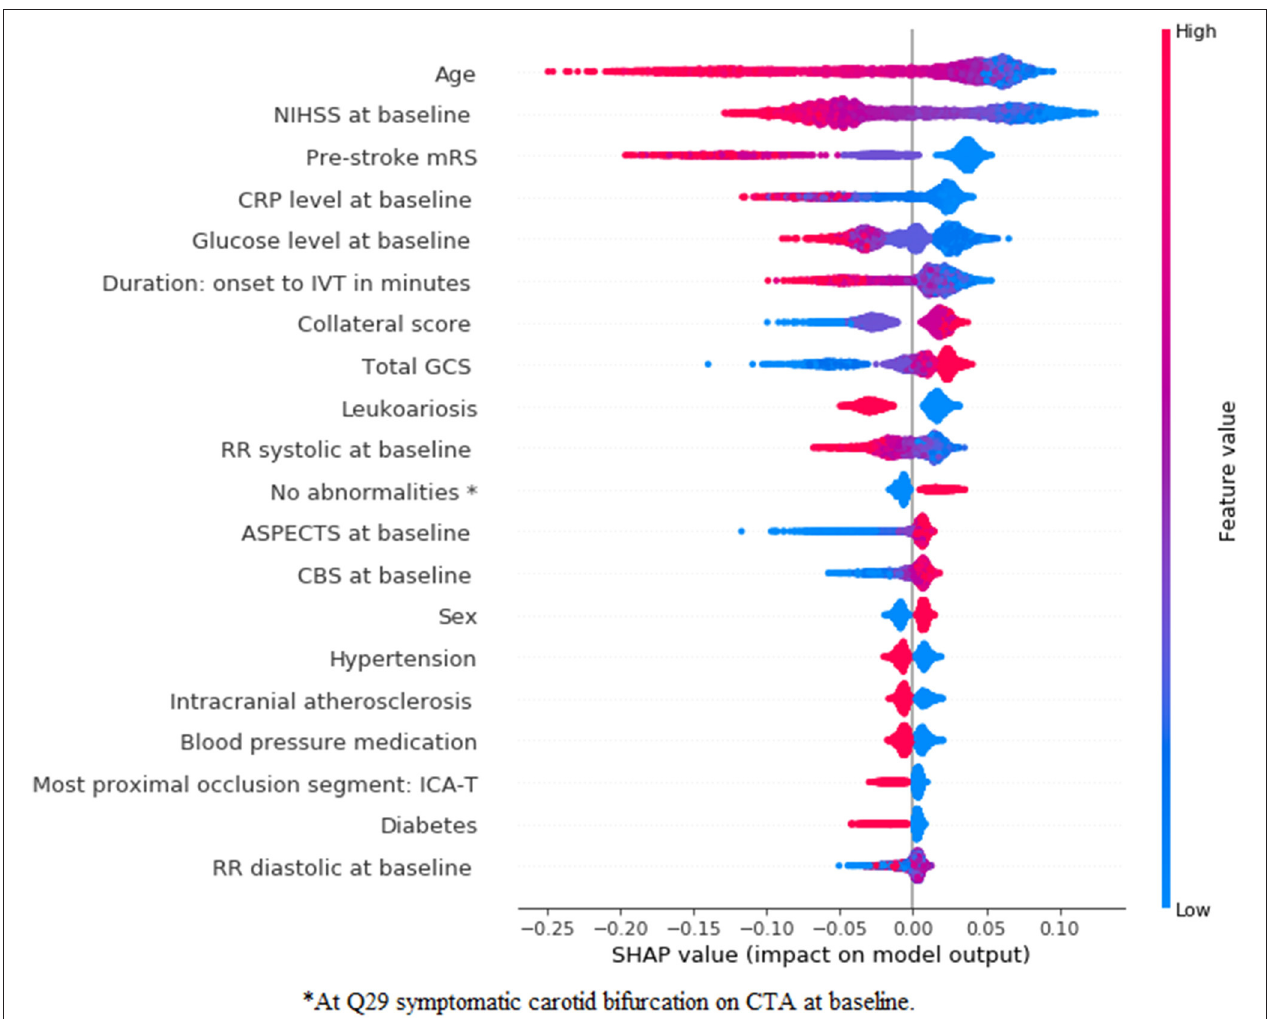
FIGURE 5 | SHapley Additive exPlanations (SHAP) feature importance for the clinical experiment for mRS prediction using the random forest classifier (RFC) model. For visualization purposes, we included only the top 20 features. Features are shown in order of importance, from most important (top) to less important (bottom). The color legend on the right shows how the feature values influence outcome: high values are depicted in red, while low values are presented in blue. Positive SHAP values (above zero in the x -axis) mean that the feature values are associated to the positive outcome (in this case good functional outcome), while SHAP values below zero indicate the opposite. * At symptomatic carotid bifurcation on CT angiography (CTA) at